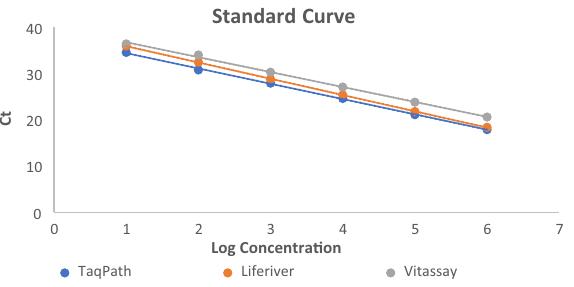
Figure 1. Standard curves established for Novel Coronavirus (2019-nCoV) Real Time Multiplex RT-PCR Kit (Liferiver), Vitassay qPCR SARS-CoV-2 (Vitassay) and TaqPath COVID-19 CE-IVD RT-PCR Kit (Thermo Fisher Scientific).